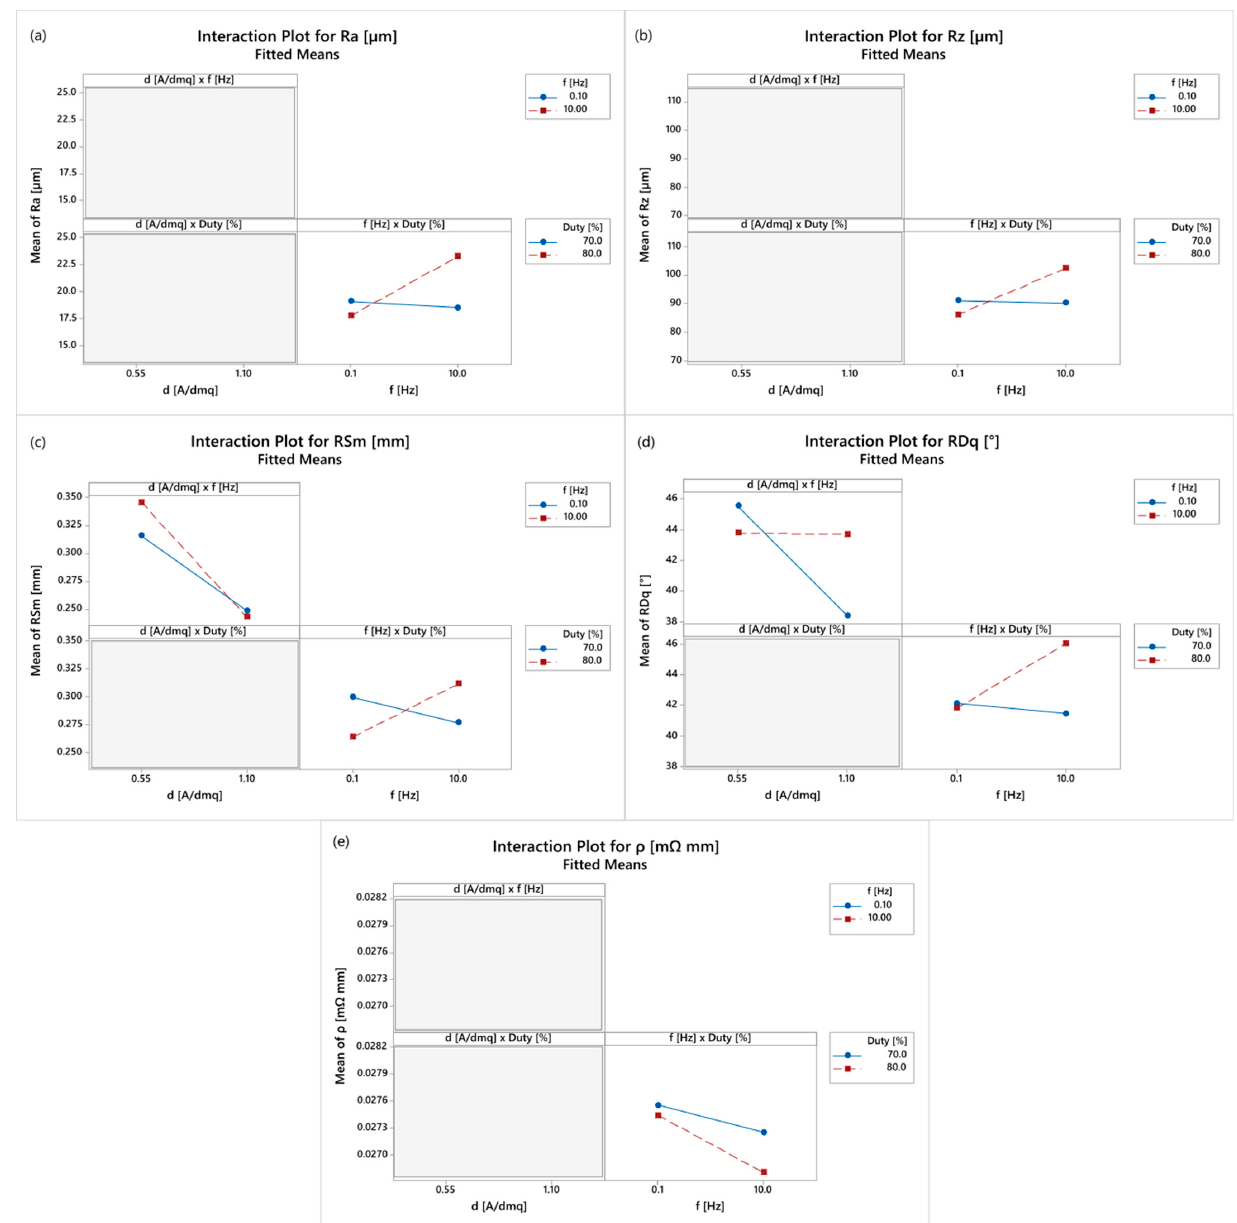
Figure 7. Interaction plots: ( a ) Ra, ( b ) Rz, ( c ) RSm, ( d ) RDq and ( e ) ρ ; not statistically significant interactions are masked or not reported.